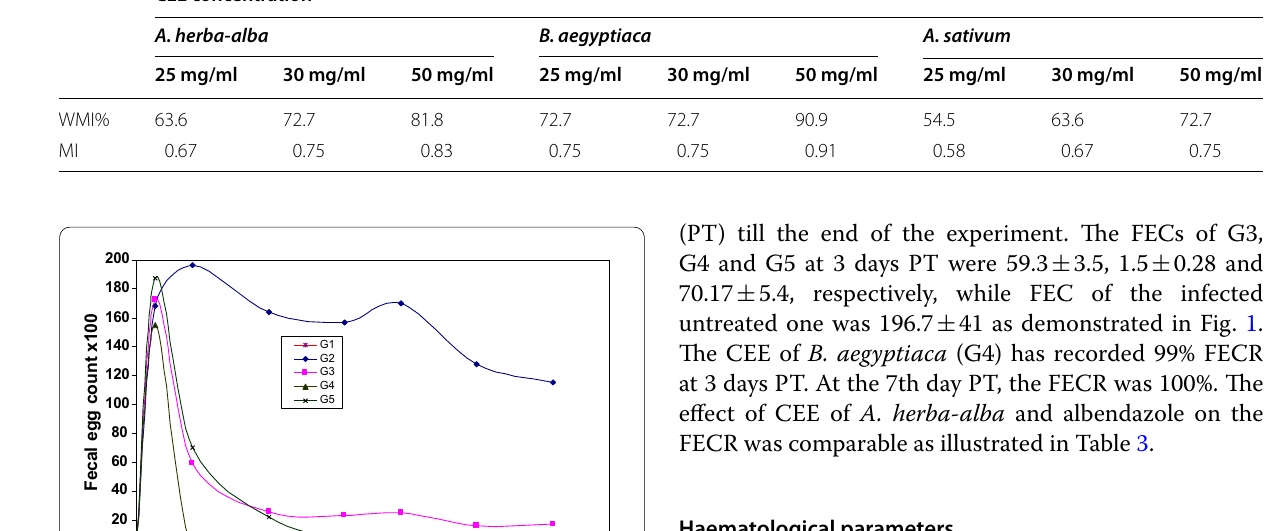
Table 2 Mean percent of worm motility inhibition and mortality index of different CEE‑treated worms at various treatments CEE concentration